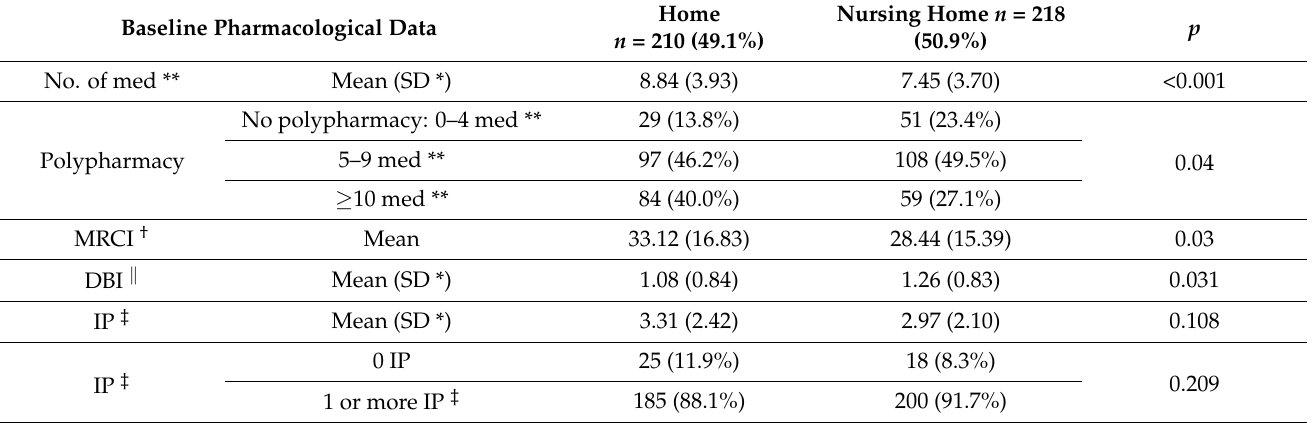
Table 3. Baseline pharmacological data for the COP-cohort according to their place of